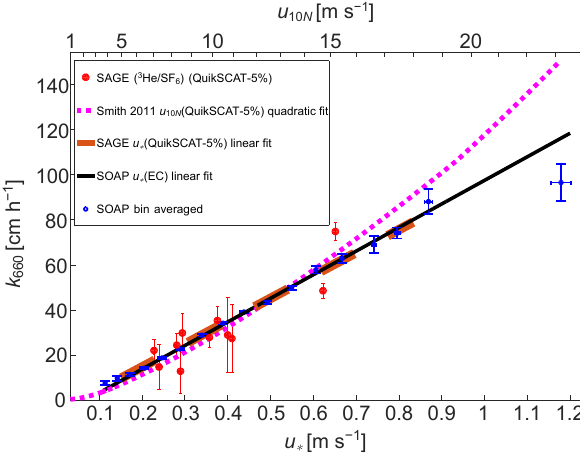
Figure 10. Schmidt number normalised gas transfer velocities ( k 660 ) from the Southern Ocean SOAP and SAGE experiments as a function of friction velocity ( u ∗ ). Red points: SAGE data from Ho et al. (2007, Table 1), with corrected QuikSCAT wind speeds fol- lowing Boutin et al. (2009) and converted to u ∗ using COARE 3.5 (see Sect. 2.5). Magenta dashed line: SAGE parameterisation from Smith et al. (2011). Orange dashed line: u ∗ linear fit to the SAGE data Eq. (11). Blue points: SOAP shown as 1ms − 1 wind-speed bin averages. Black line: SOAP u ∗ linear regression (Eq. 10). The error bars indicate the standard error of the